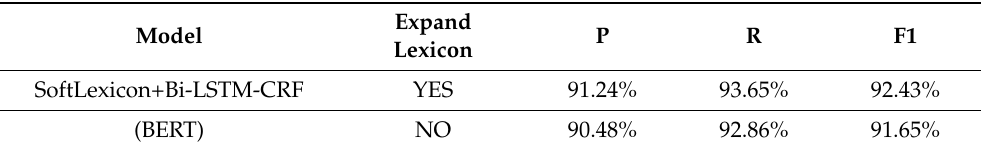
Table 6. Experimental results of two models on the power grid dataset. “Expand Lexicon” denotes whether the model uses the expanded lexicon.